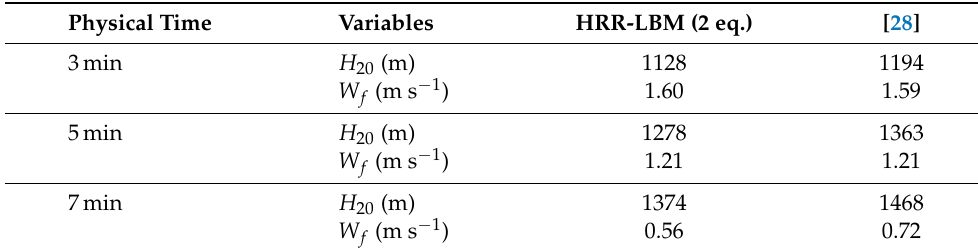
Table 1. Highest vertical location of the 20% maximum q l contour ( H 20 ) and vertical fluid velocity at the top central position of the interface ( W f ) at 3, 5 and 7min.